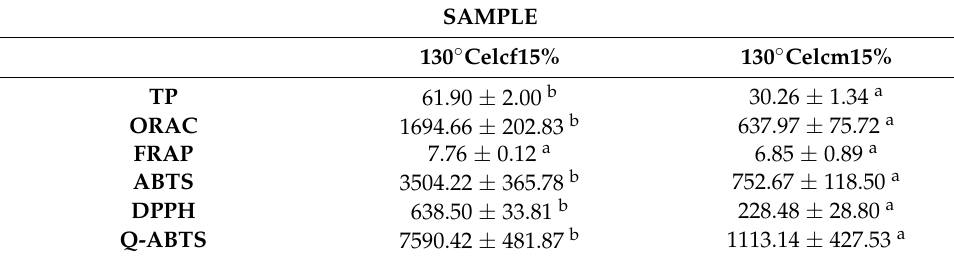
Table 6. Total phenol (TP, mg GAE 100 g − 1 dry matter), total antioxidant activity as ORAC, ABTS •